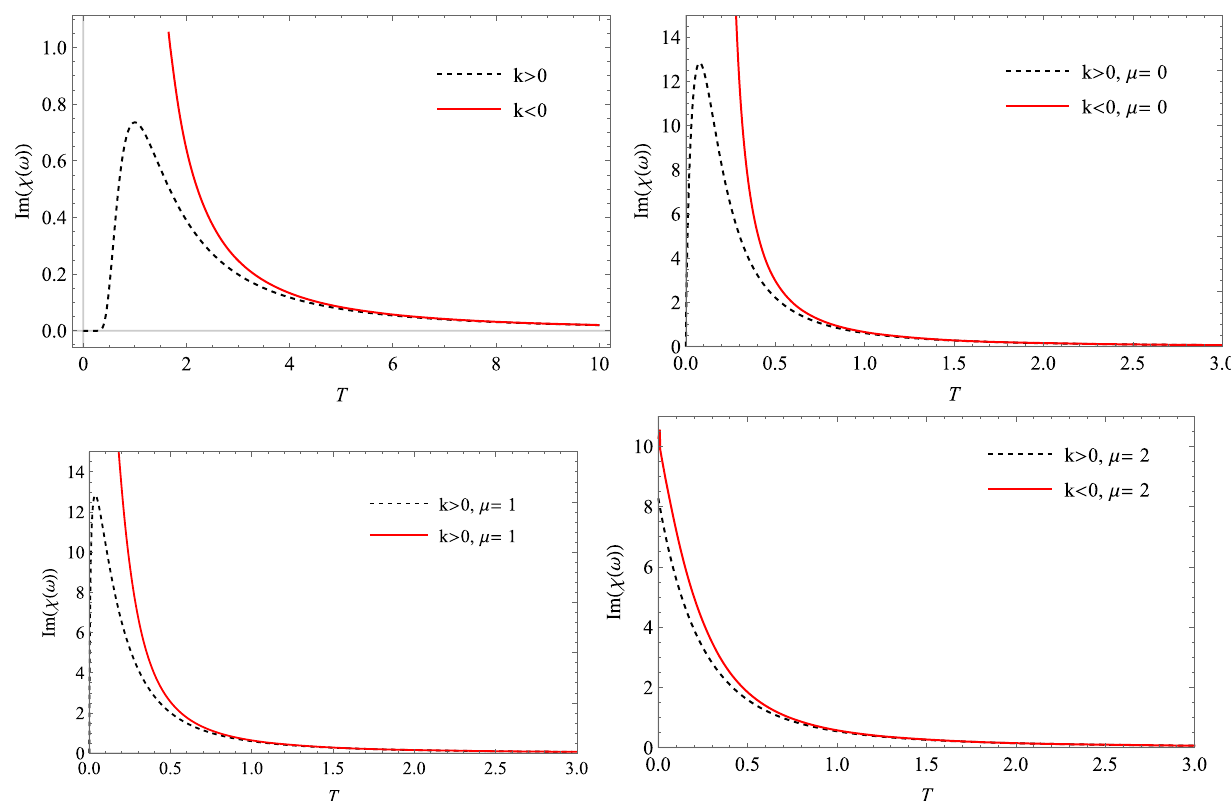
Fig. 3 Imaginary part of the admittance, as a function of the tempera- ture ( T ) for k = ± 0 . 18, in various scenarios. Upper left panel: results from Ref. [54] where the backreaction contributions were not consid- ered. Upper right panel: results from Ref. [55] where the backreaction